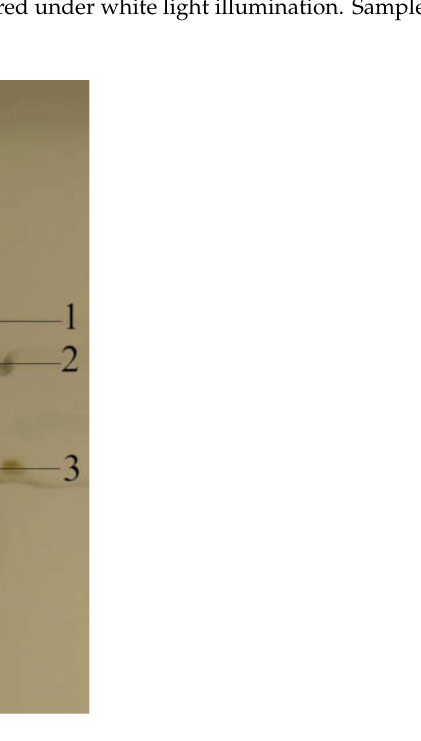
Figure 5. The track of chromatogram after focusing the substance of interest (salinomycin) and the internal standard (nigericin) at the solvent front position. ( 1 ) Low-retention matrix components, ( 2 ) the zone of substance of interest (salinomycin) and the internal standard (nigericin), ( 3 ) high-retention matrix components. Stationary phase: HPTLC Silica gel. Plate image was captured under white light